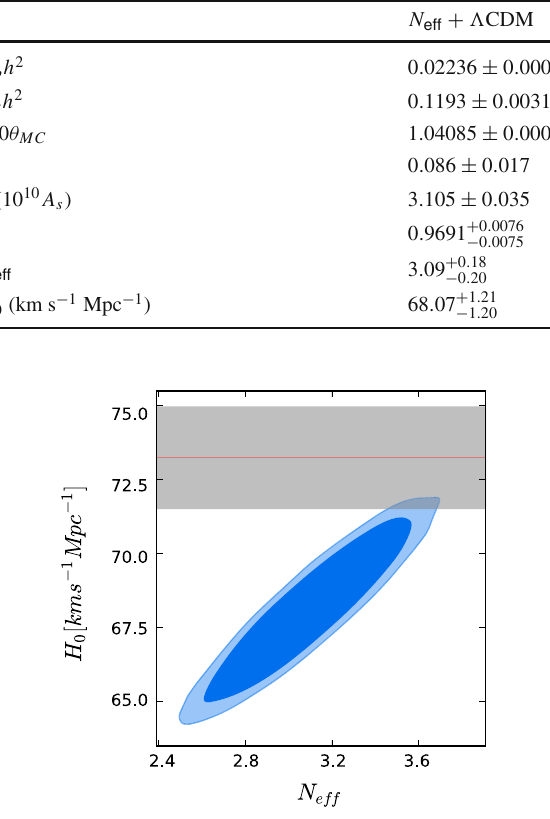
Fig. 4 The 2D contour plot of H 0 and N eff in the N eff + (cid:2) CDM model. The rectangle shaded region represents the observational value H 0 = 73 . 24 ± 1 . 74kms − 1 Mpc − 1